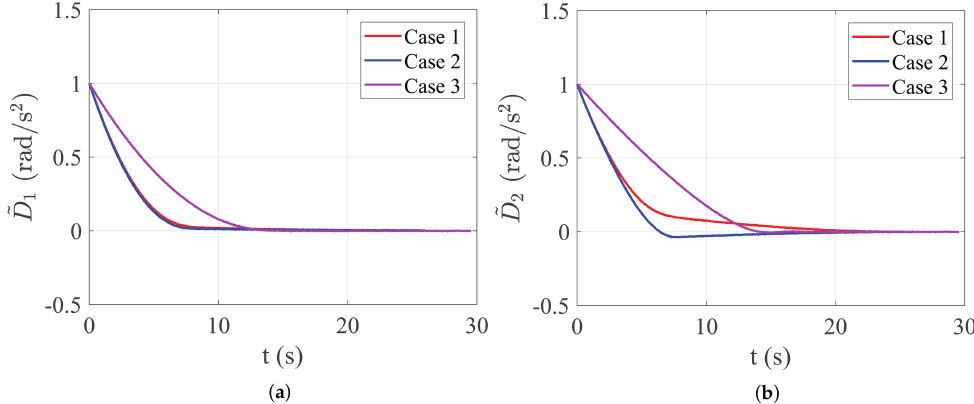
Figure 5. Variations of estimation errors against constant maneuvering targets: ( a ) estimation errors in pitch plane; ( b ) estimation errors in yaw plane.